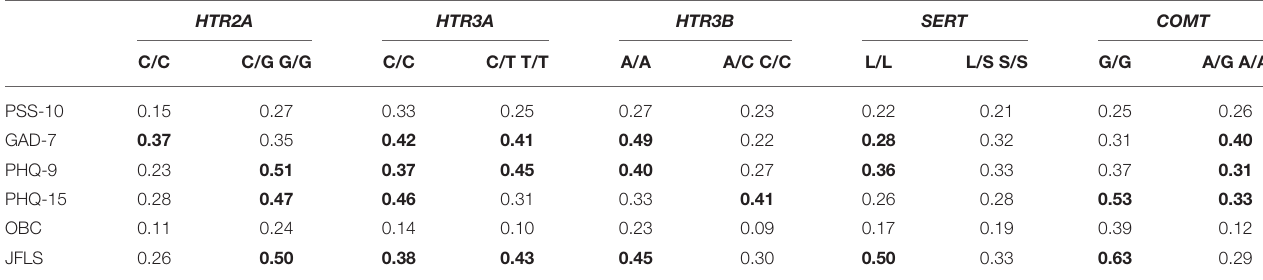
TABLE 4 | Spearman’s correlations coefficients ( r s ) between characteristic pain intensity on one hand, and psychological distress (PSS-10, GAD-7, PHQ-9, PHQ-15) and parafunctions (OBC) on the other hand, in 117 TMD myalgia patients grouped according to the common homozygous and rare homozygous combined with the heterozygous genotypes for the HTR2A (rs9316233), HTR3A (rs1062613), HTR3B (rs1176744), SERT (5-HTTLPR) , and COMT (rs4680) polymorphisms.